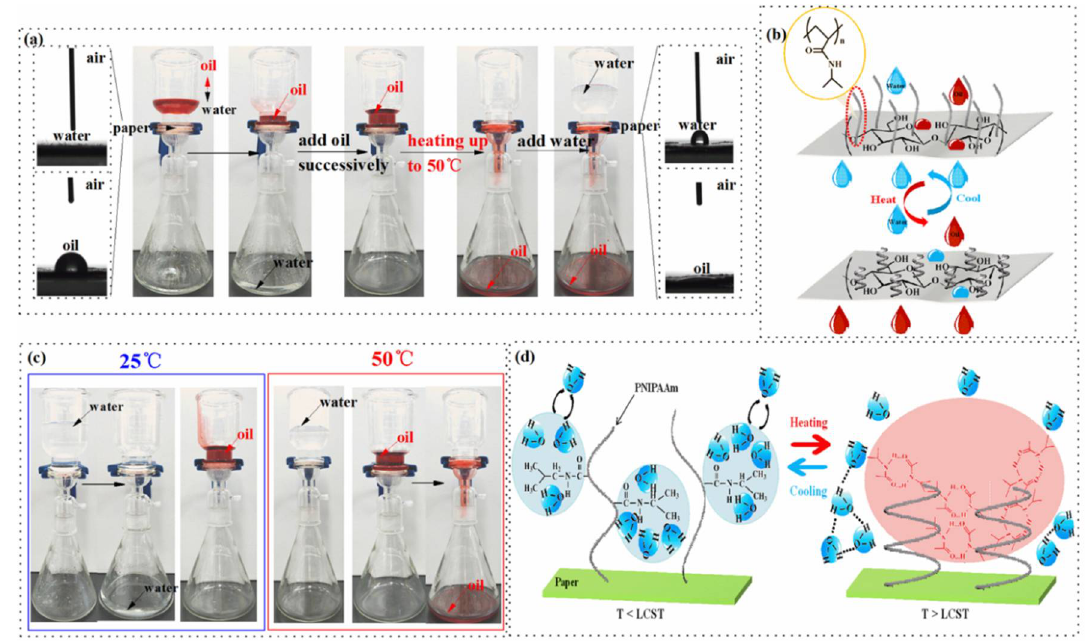
Figure 11. The time sequence of the oil/water separation process with cellulose- g -PNIPAAm paper ( a ). The oil/water mixture is composed of oil (dyed by sudan (III)/water). The left and right insets show the water droplet ( top ) and the oil droplet ( bottom ) on the corresponding cellulose- g -PNIPAAm, which is a schematic description ( b ); a contrast oil-only/water-only liquid filtration with the cellulose- g -PNIPAAm paper at 25 °C and 50 °C, respectively ( c ); the molecular mechanism diagram of the cellulose- g -PNIPAAm paper’s thermal-responsive wettability. Cellulose forms the main structure of the paper, while the reversible formation of the intermolecular and intra-molecular hydrogen bonding of PNIPAAm below and above the Lower Critical Solution Temperature exhibit the thermally-responsive wettability of the paper ( d ).